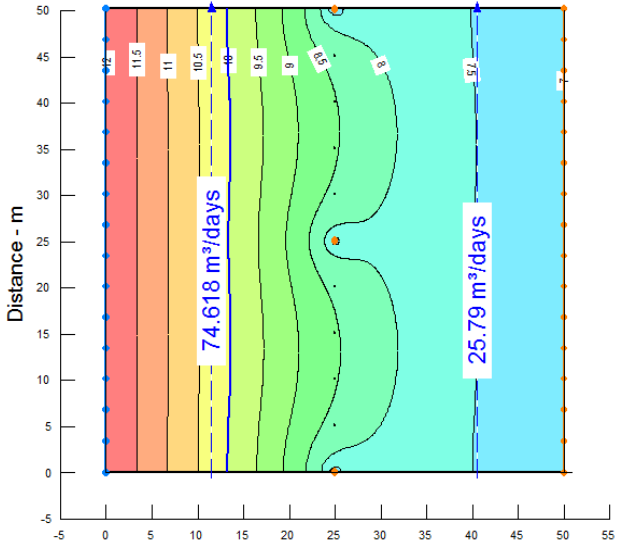
Fig. 7. Relief wells plan at toe of earth dam by 0.1 m radius and 25 m distance from each